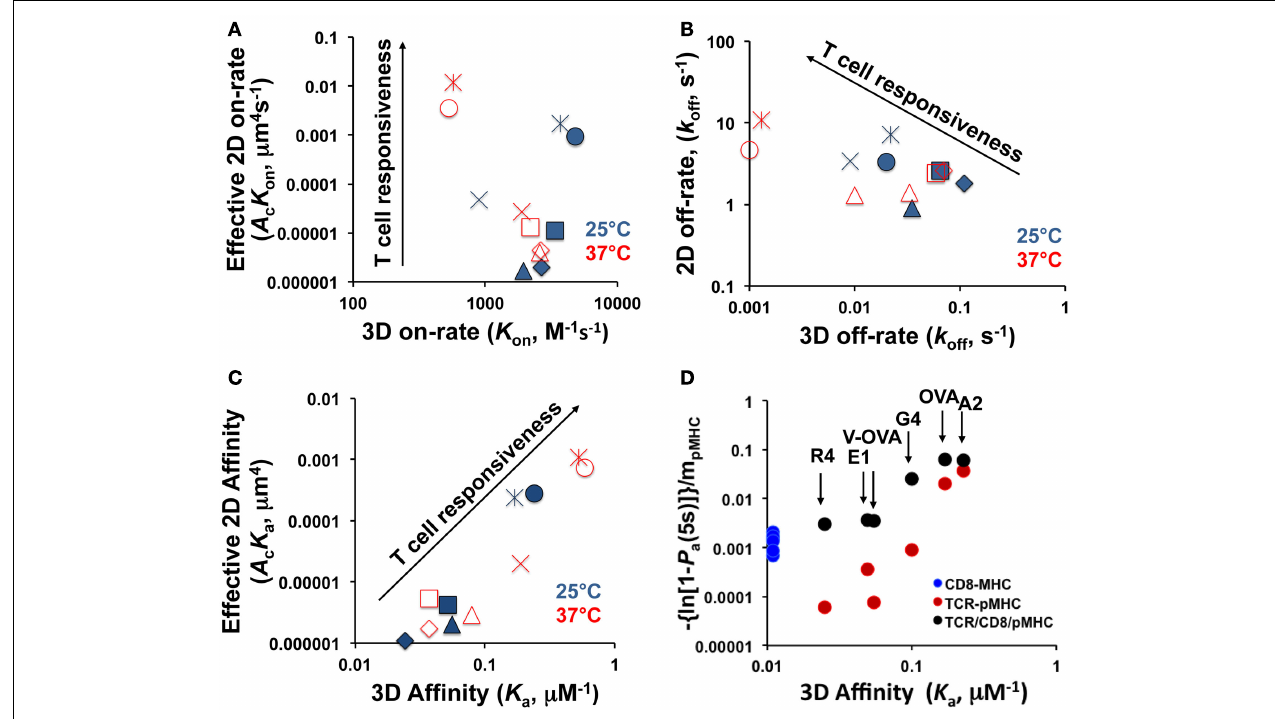
Normalized adhesion bonds at equilibrium, calculated by converting the steady-state adhesion frequency P a to the average number of bonds, − ln(1 − P a ), normalized by pMHC density, m pMHC , ofTCR:pMHC (red circles) and pMHC:CD8 (blue circles) bimolecular interactions as well as TCR:pMHC:CD8 (black circles) trimolecular interactions are plotted versus 3D affinities of the correspondingTCR:pMHC and pMHC:CD8 bimolecular interactions.The 3D affinities forTCR:pMHC are the same as those in panel C and that for pMHC:CD8 interaction is from (Leishman et al., 2001). The 2D normalized bond values are from (Jiang et al., 2011).The corresponding peptides in the pMHC complexes are